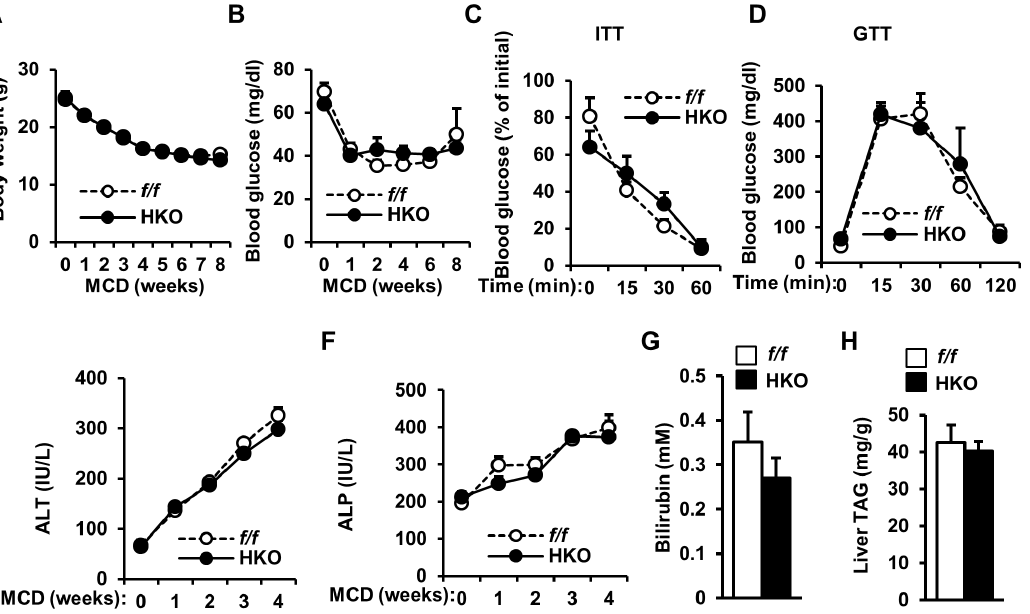
Figure 6. Liver-specific deletion of SH2B1 does not augment MCD-induced liver injury. Male mice (7 weeks of age) were fed a MCD. (A) Growth curves. f/f : n=5; HKO: n=7. (B) Overnight fasting blood glucose. f/f : n=5; HKO: n=5. (C) ITT (MCD for 7 weeks). f/f : n=5; HKO: n=5. (D) GTT (MCD for 6 weeks). f/f : n=5; HKO: n=5. (E) Plasma ALT activity. f/f : n=5; HKO: n=5. (F). Plasma ALP activity. f/f : n=5; HKO: n=5. (G) Plasma bilirubin levels (MCD for 8 weeks). f/f : n=5; HKO: n=5. (H) Liver TAG levels (MCD for 8 weeks). f/f : n=5; HKO: n=5. Data are presented as means 6 SEM. P , 0.05.